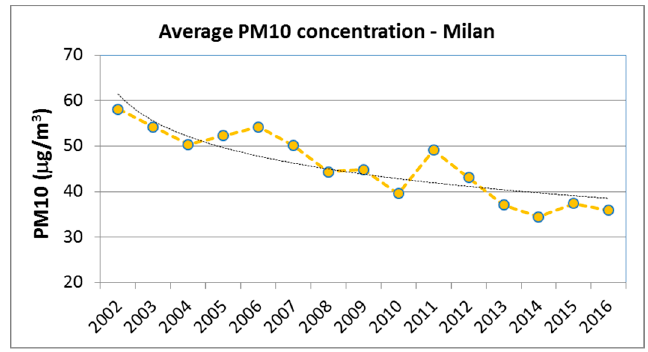
Figure 4. Yearly average particulate matter with diameter smaller than 10 μ m (PM 10 ) concentration in Milan and a possible interpolating trend (data from [43]).